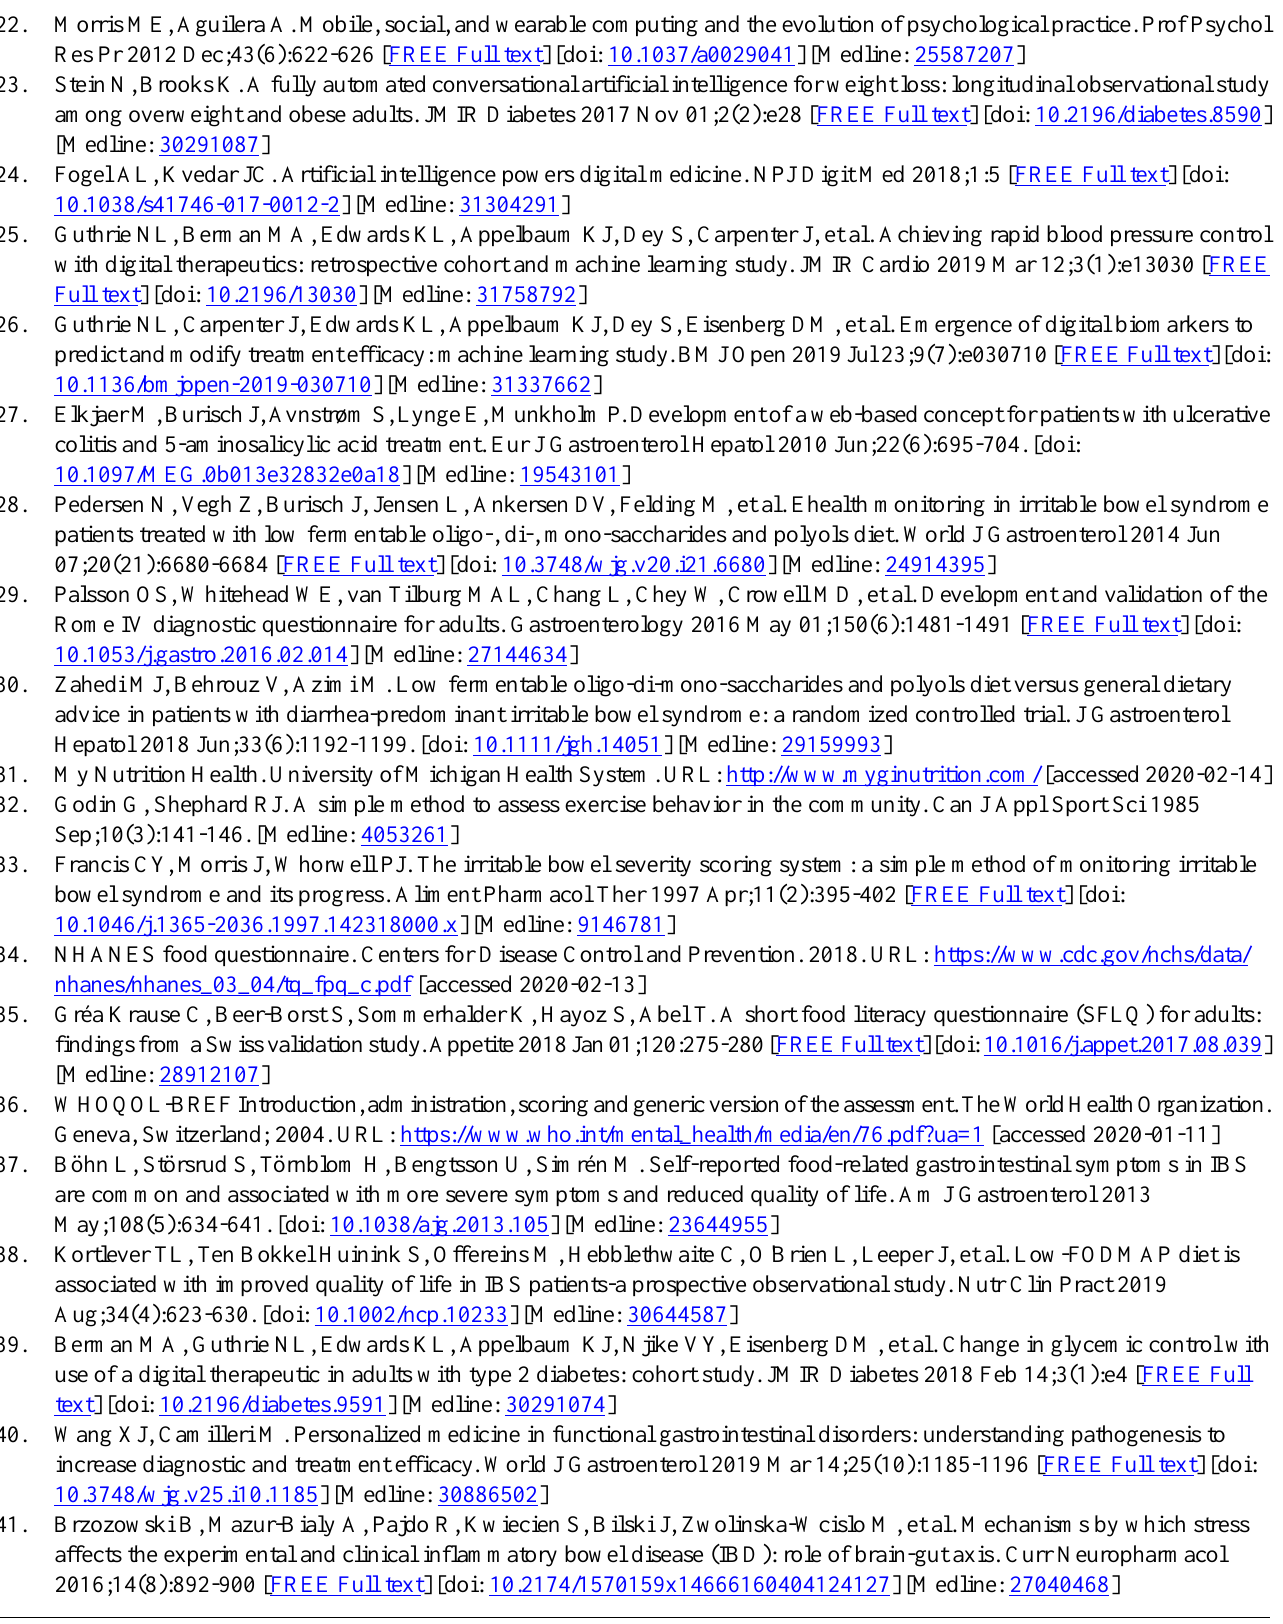
Abbreviations AI: artificial intelligence APP: experimental group (access to artificial intelligence dietary mobile app) CON: control